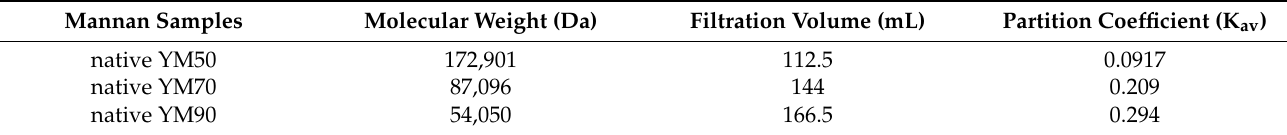
Figure 2. Sephadex CL-6B gel filtration column chromatogram of mannans. ( A – C ) were the elution profile of YM50, YM70 and YM90 mannans, respectively. Table 1. Molecular weight distribution of mannans.